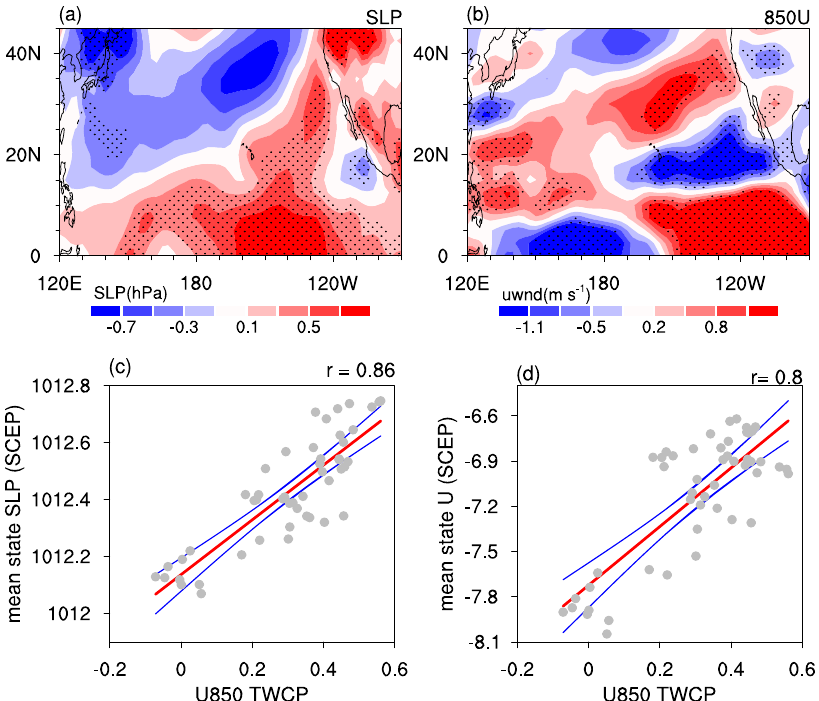
Fig. 5 Paci fi c mean states change. Differences in the climatology of spring a SLP and b 850-hPa zonal wind between periods 1996 – 2018 and 1949 – 1995. Stippling regions in a , b indicate the differences that are signi fi cantly different from zero at the 95% con fi dence level. Scatter plots of the Mar(0) ALI-related 850-hPa zonal wind anomalies in AM(0) averaged over the TWCP against the climatology of spring c SLP and d 850- hPa zonal wind over the subtropical northeastern Paci fi c for the 23-year running period. Red lines indicate the best linear fi t. Blue lines indicate the 95% con fi dence range of the linear